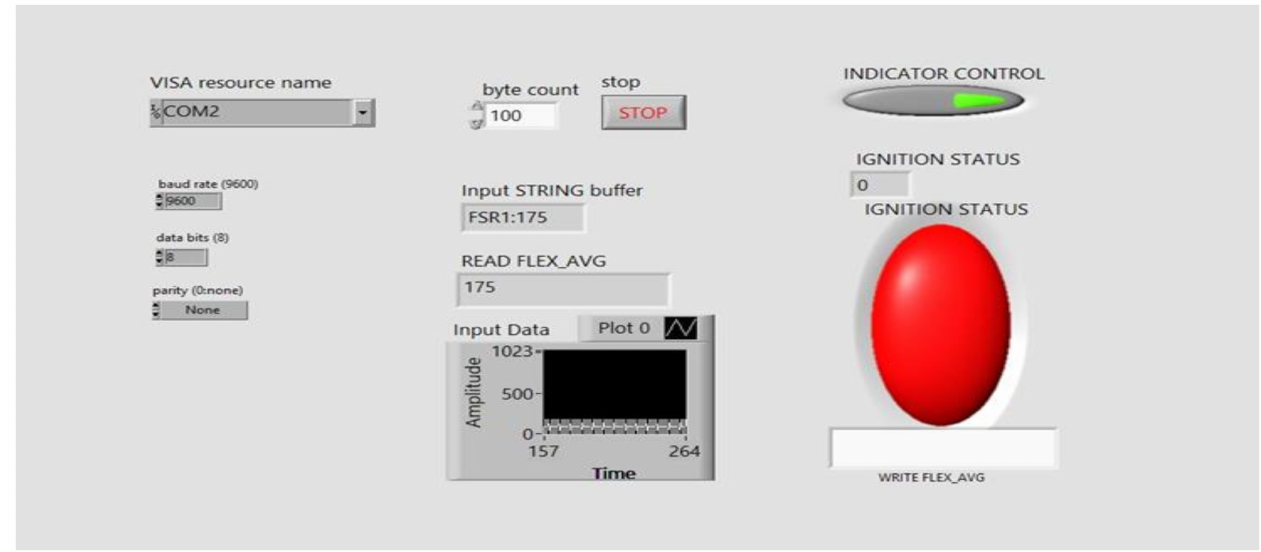
Figure 17. Front panel for Lab VIEW for system analysis showing the vehicle is not